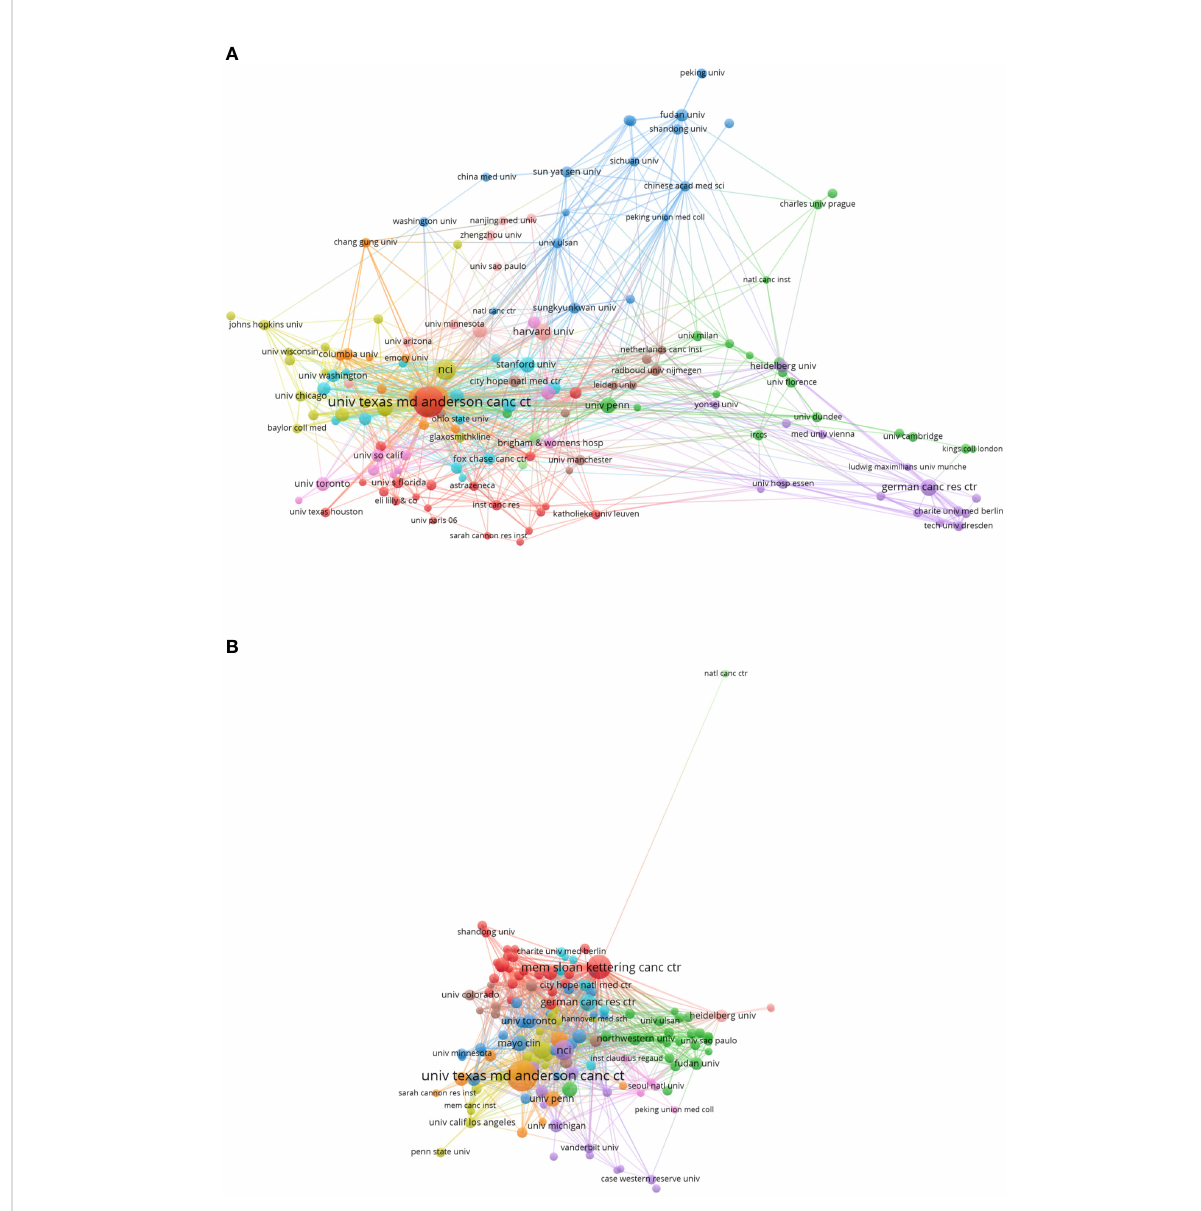
FIGURE 4 (A) The institutions ’ collaboration network visualization map generated by VOS viewer (version5.8 R3) (B) The institutions ’ citation network visualization map generated by VOS viewer (version5.8